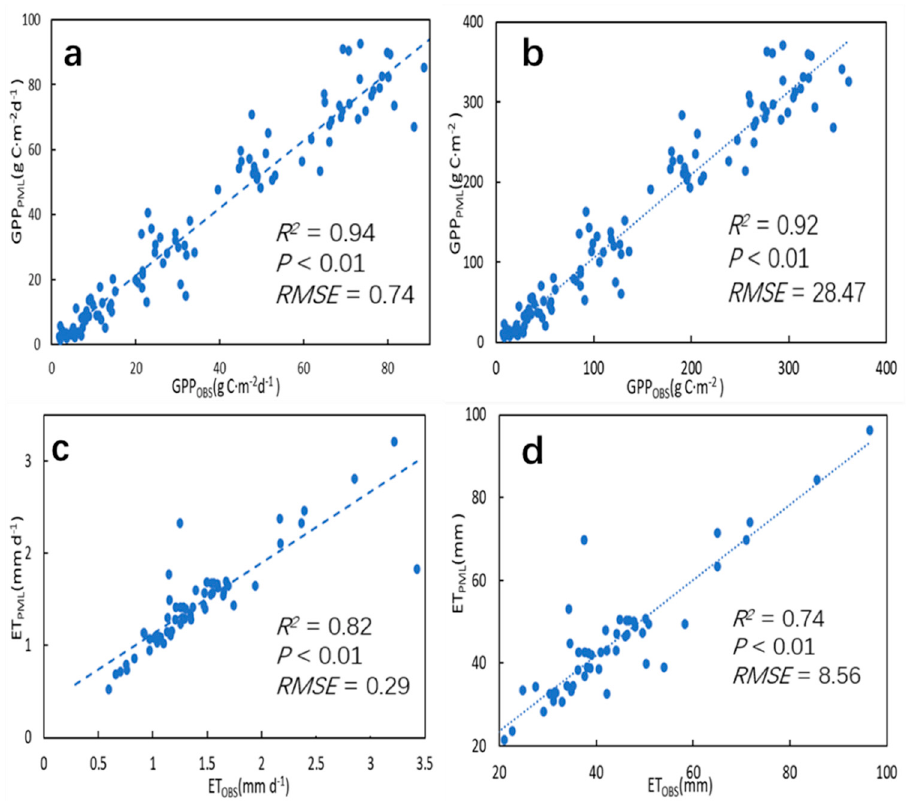
Figure 2. Validation diagrams of GPP and ET remote sensing products of PML data at 8 day scale ( a , c ) and monthly scale ( b , d ).